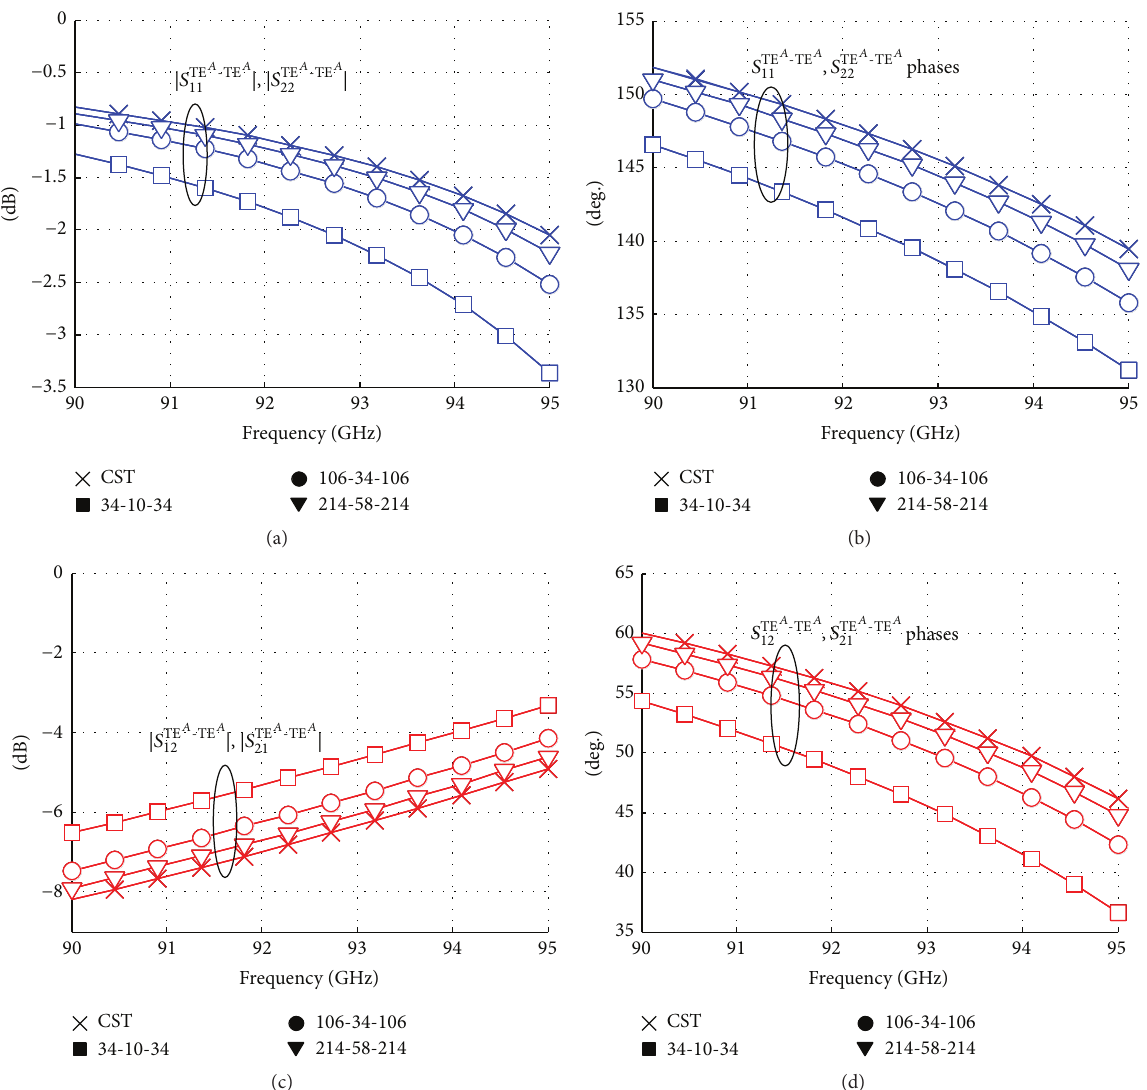
Figure 12: Case study c: mode TE 𝐴 10 in waveguide 1 to mode TE 𝐴 10 in waveguide 2 : (a) reflection magnitude, (b) reflection phase, (c) transmission magnitude, and (d) transmission